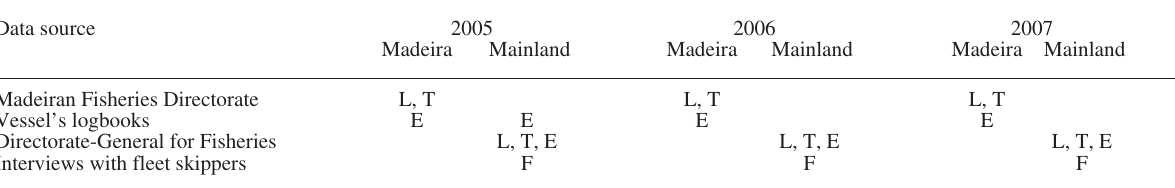
Table 1. – summary of the data types analysed by source, year and